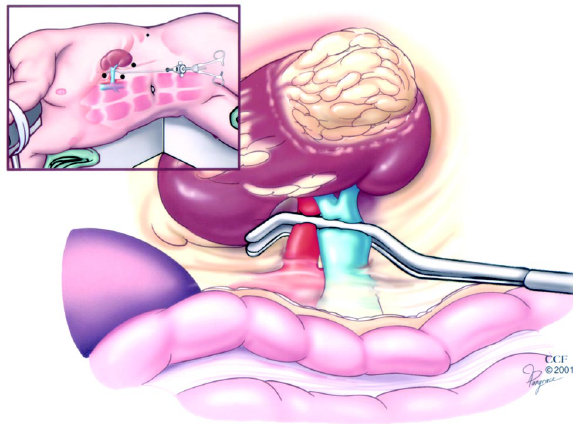
Figure 1 – Transperitoneal technique of laparoscopic partial nephrectomy. Laparoscopic Satinsky clamp is used to obtain en bloc control of renal hilum. Inset shows port arrangement. Adapted from reference 10. (Reprinted with the permission of the Cleveland Clinic Foundation).